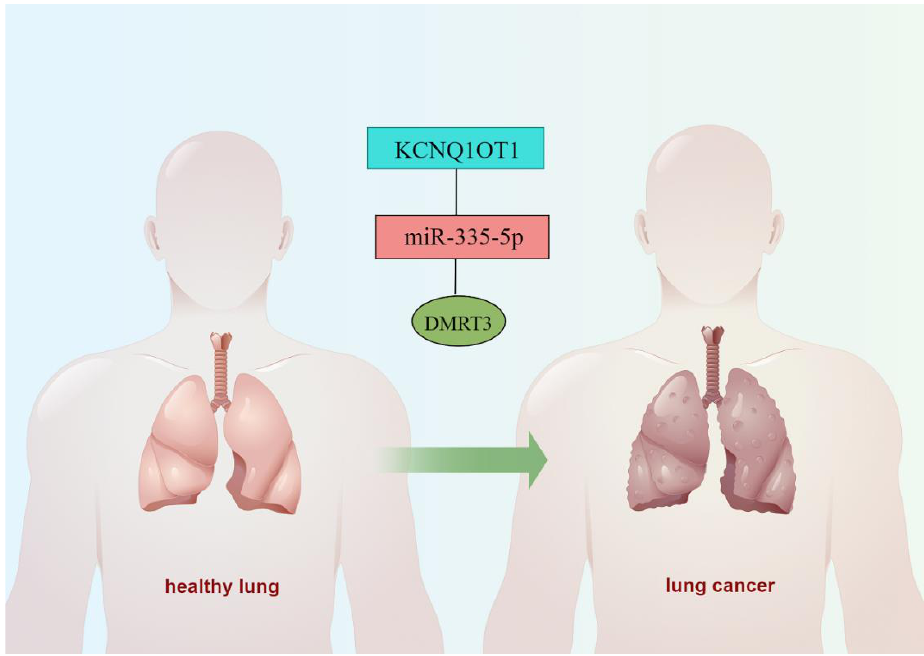
Figure 12. A possible ceRNA network for the DMRT3-mediated development of LUAD.